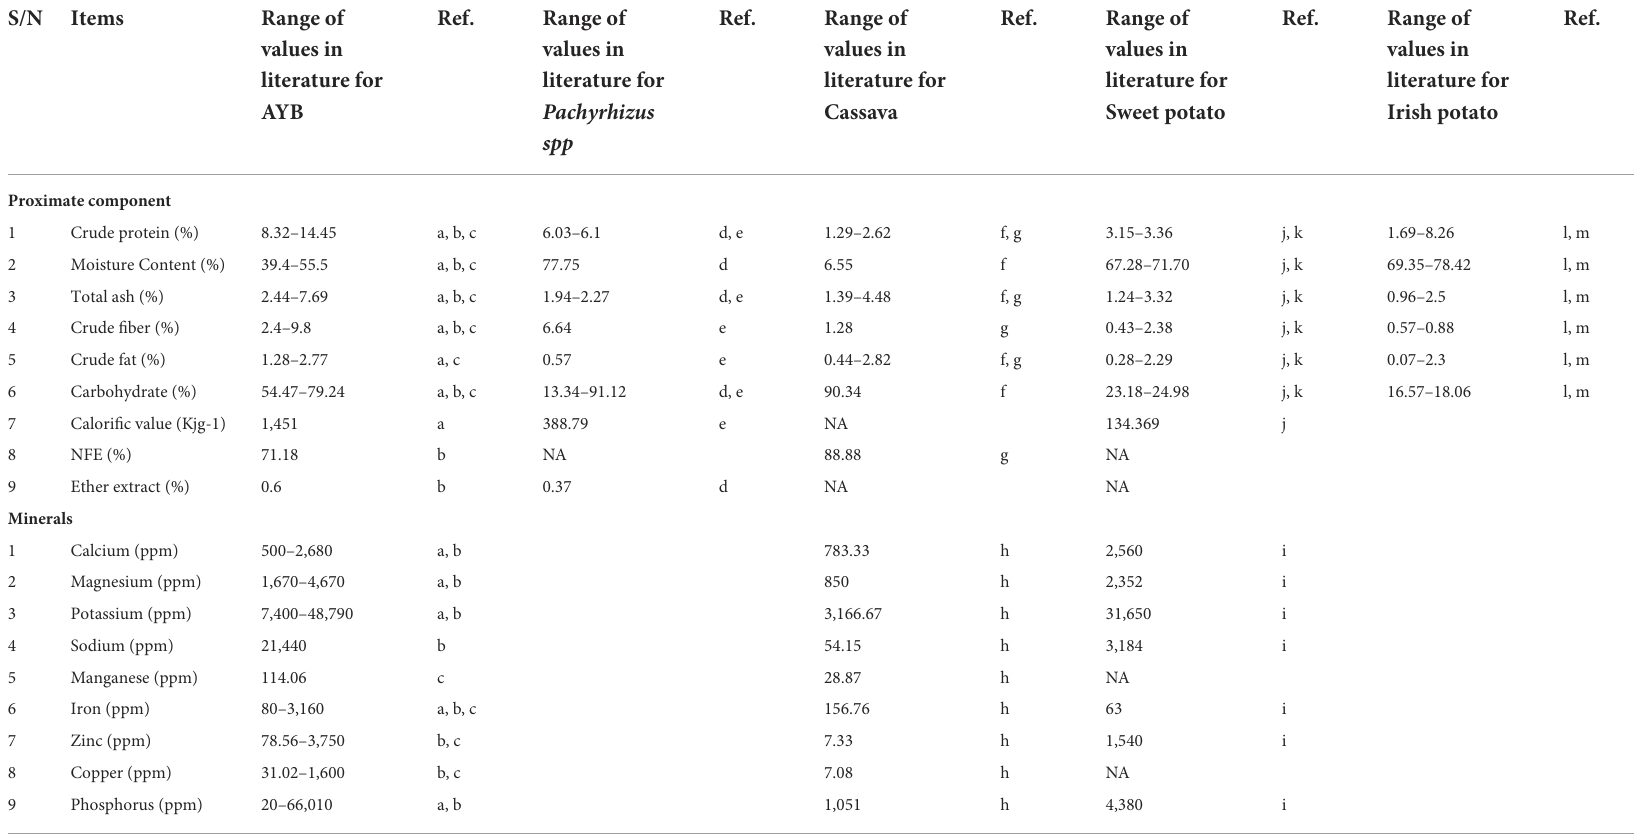
TABLE 5 Ranges in proximate and mineral contents in the tuber of African yam bean, Pachyrhizus , cassava, sweet and irish potato as revealed in